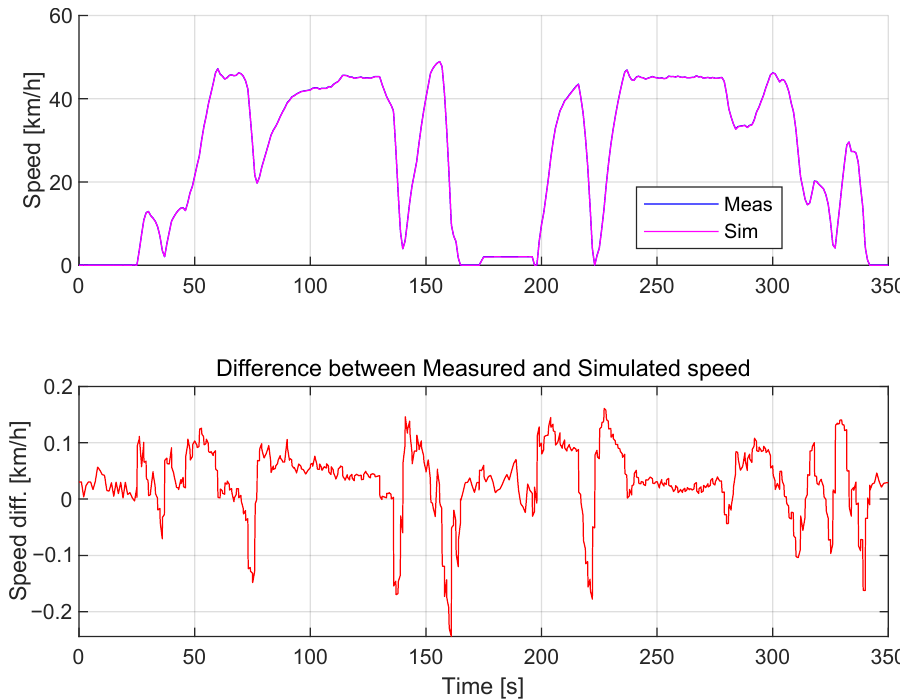
Figure 12. Comparison of measured and simulated